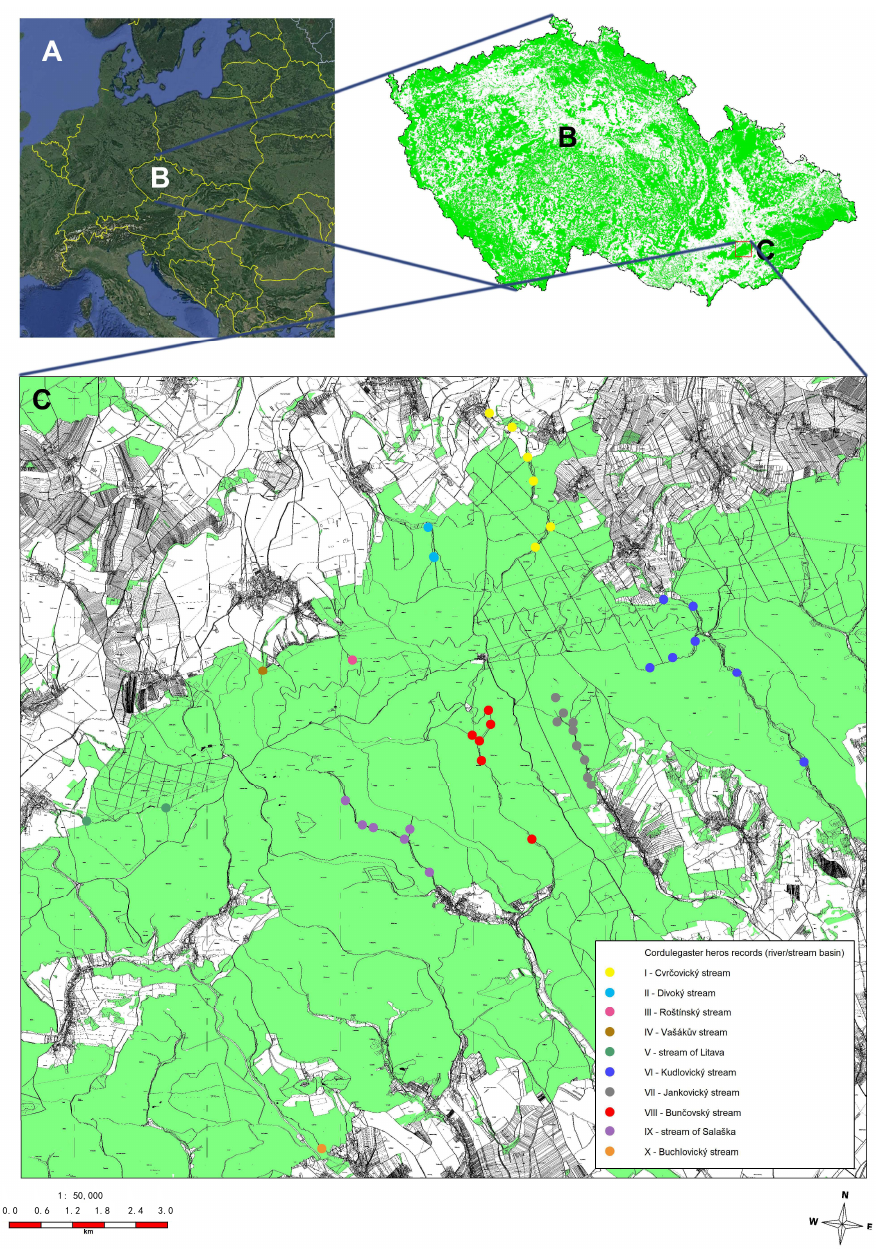
Figure 2. Study area of northernmost population C. heros in the Chˇriby hills in the Czech Republic. ( A ) Map of Western, South, and Central Europe. ( B ) Map of Czech Republic with occurrence of forests (green). ( C ) Region of the Chˇriby hills in the Czech Republic with C. heros records in individual watershed in an area of forest stands